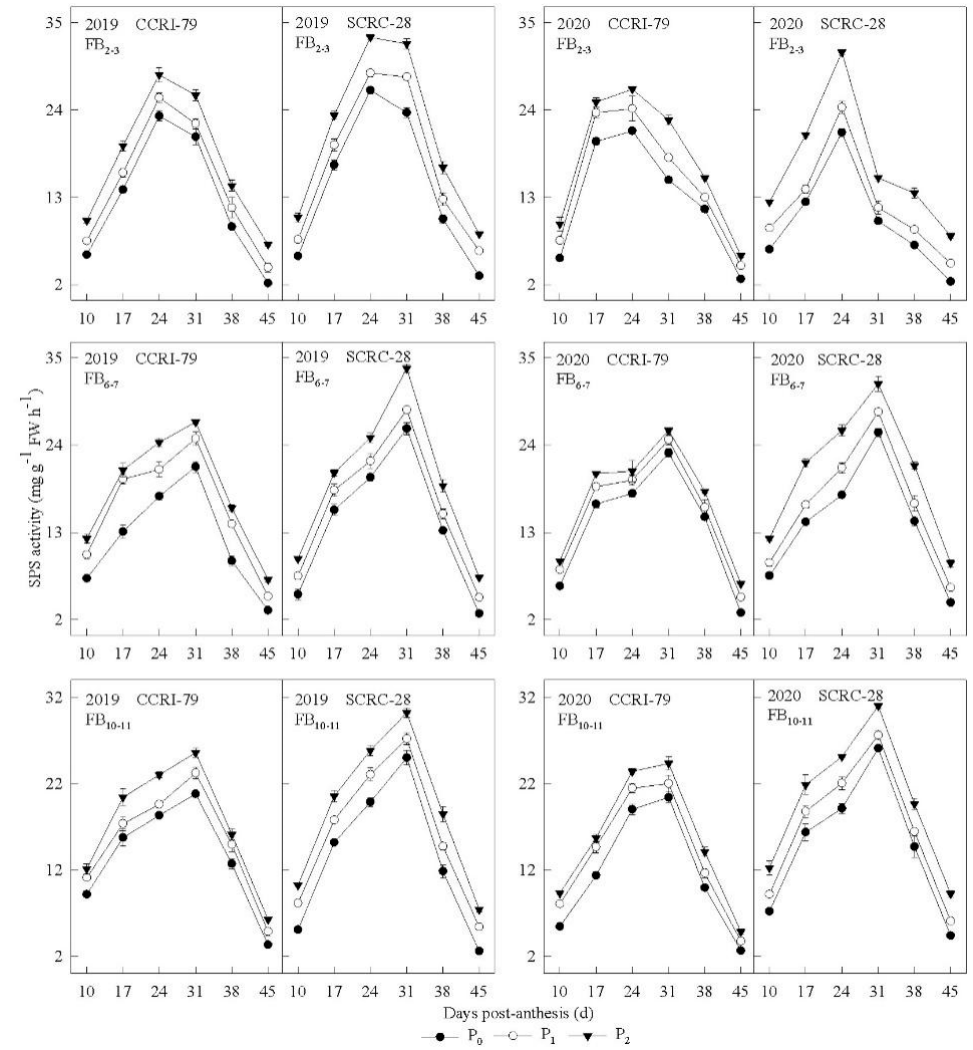
Figure 9. The effect of soil available phosphorus (AP) on the sucrose phosphate synthase (SPS) activity of subtending leaves in 2019 and 2020 cotton-growing seasons. d: day. FB: fruiting branch. P 0 : 3 ± 0.5 mg kg − 1 . P 1 : 6 ± 0.5 mg kg − 1 . P 2 : 15 ± 0.5 mg kg − 1